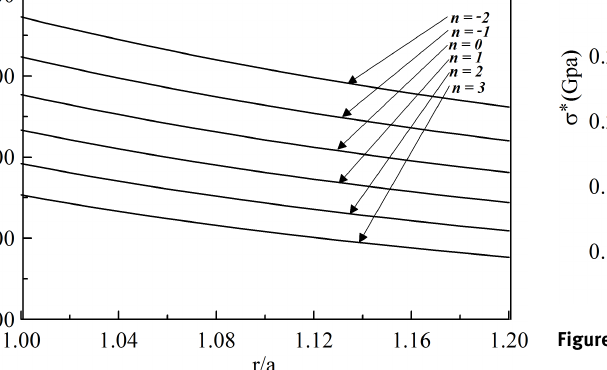
Figure 27: Radially distributed displacement